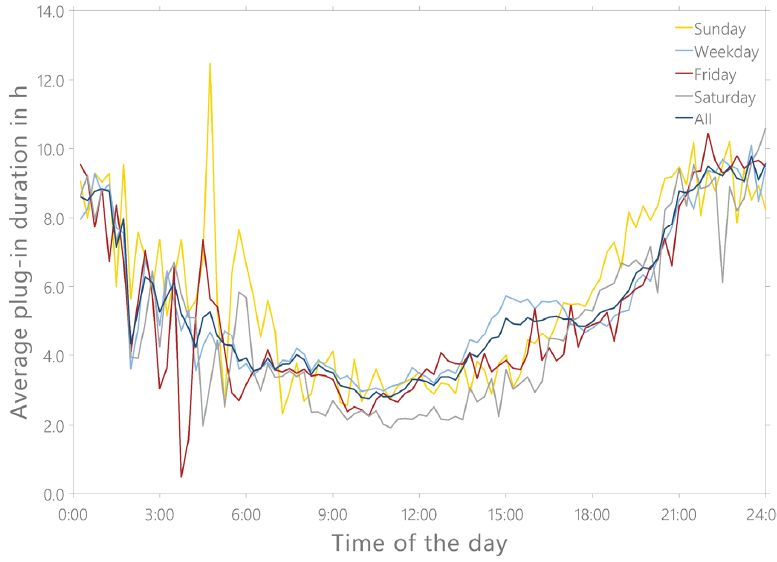
Figure 8. Average plug-in duration classified by type-days in 15 min resolution.